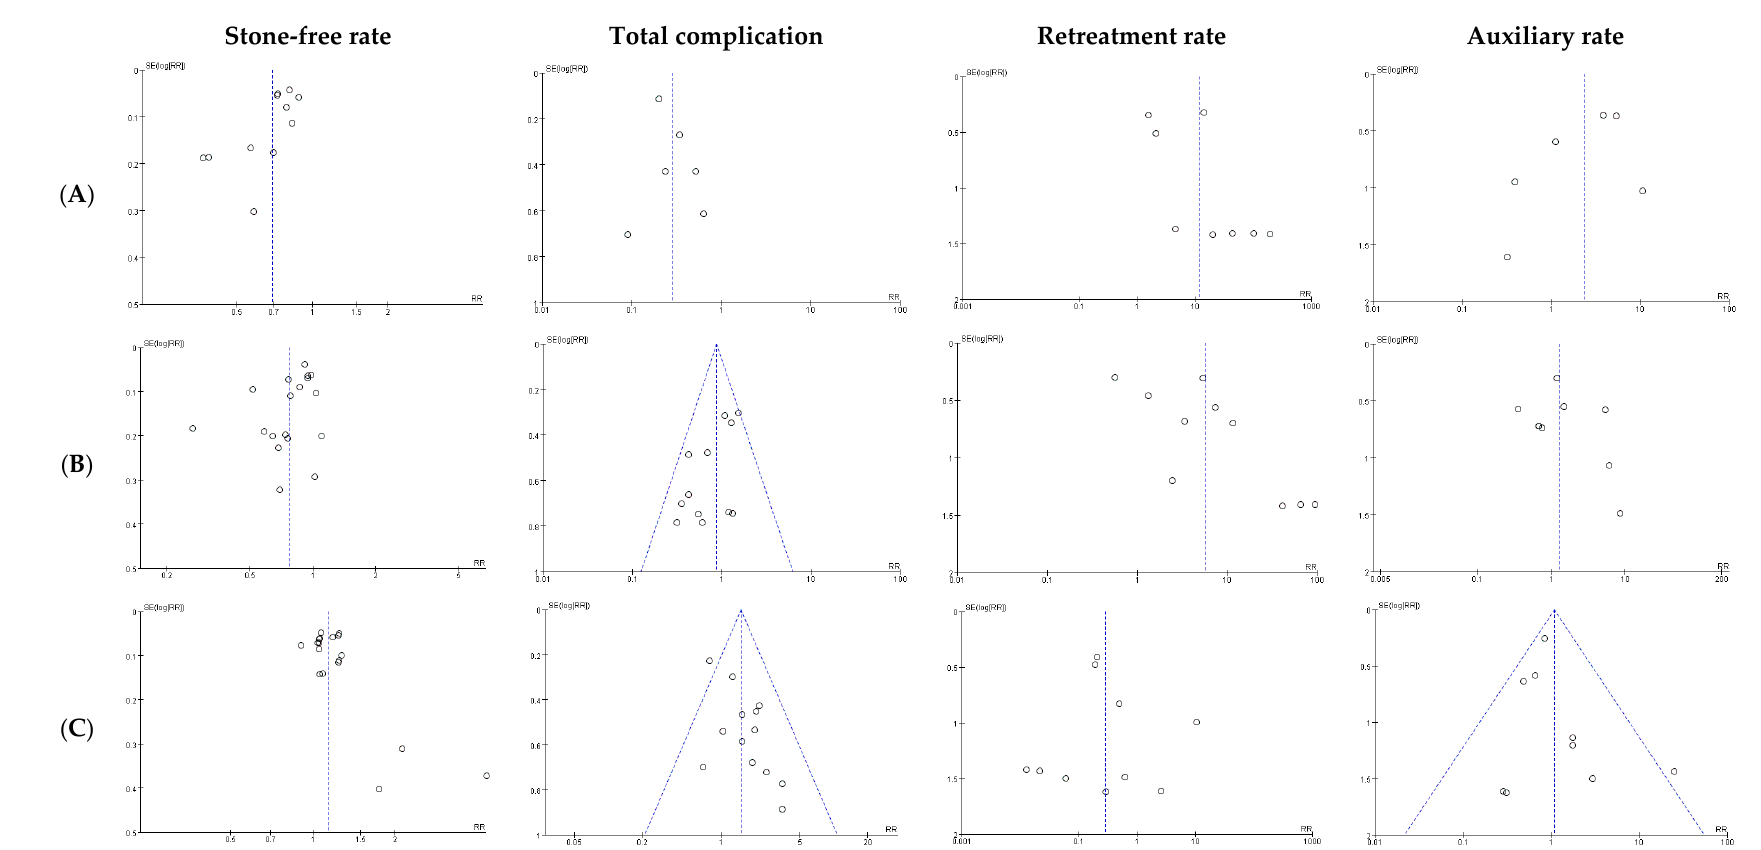
Figure 2. Funnel plot of the meta-analysis. ( A ) ESWL vs. PCNL; ( B ) ESWL vs. RIRS; ( C ) RIRS vs. PCNL. These funnel plots indicate the presence of little publication bias in all studies.